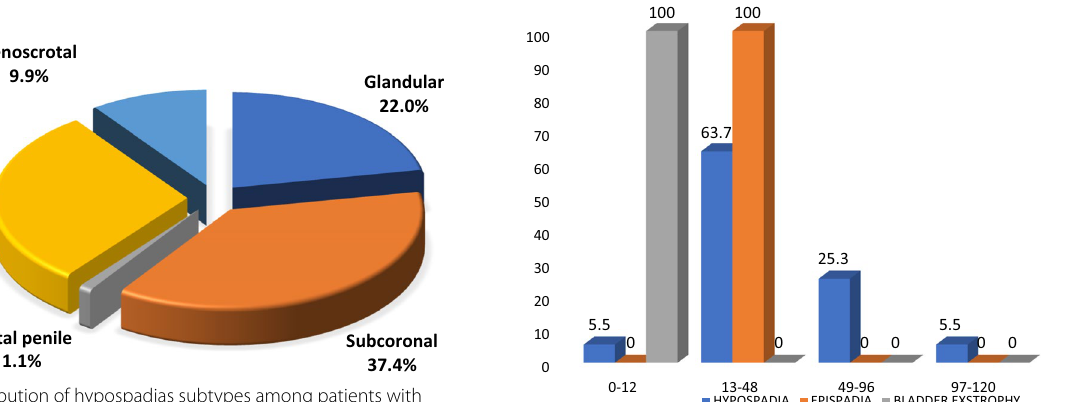
Fig. 2 Distribution of hypospadias subtypes among patients with hypospadias Fig. 3 Distribution of clinically apparent urethral anomalies based